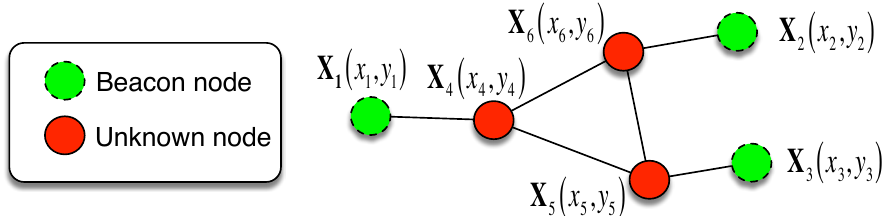
Figure 1. An example network topology consists of three beacons X 1 − X 3 and three unknown nodes X 4 − X 6 . An edge is drawn between each pair of nodes that can directly communicate with each